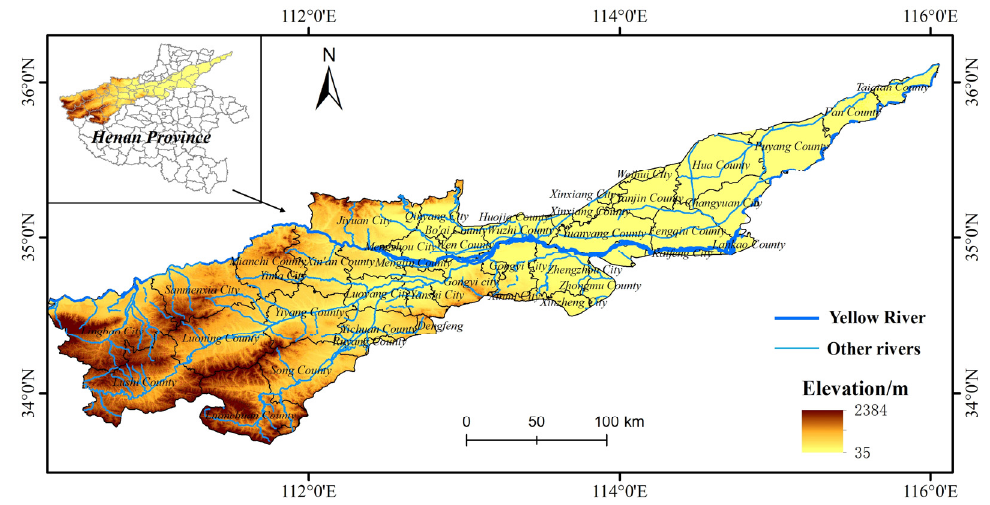
Figure 1. Location of the research area.